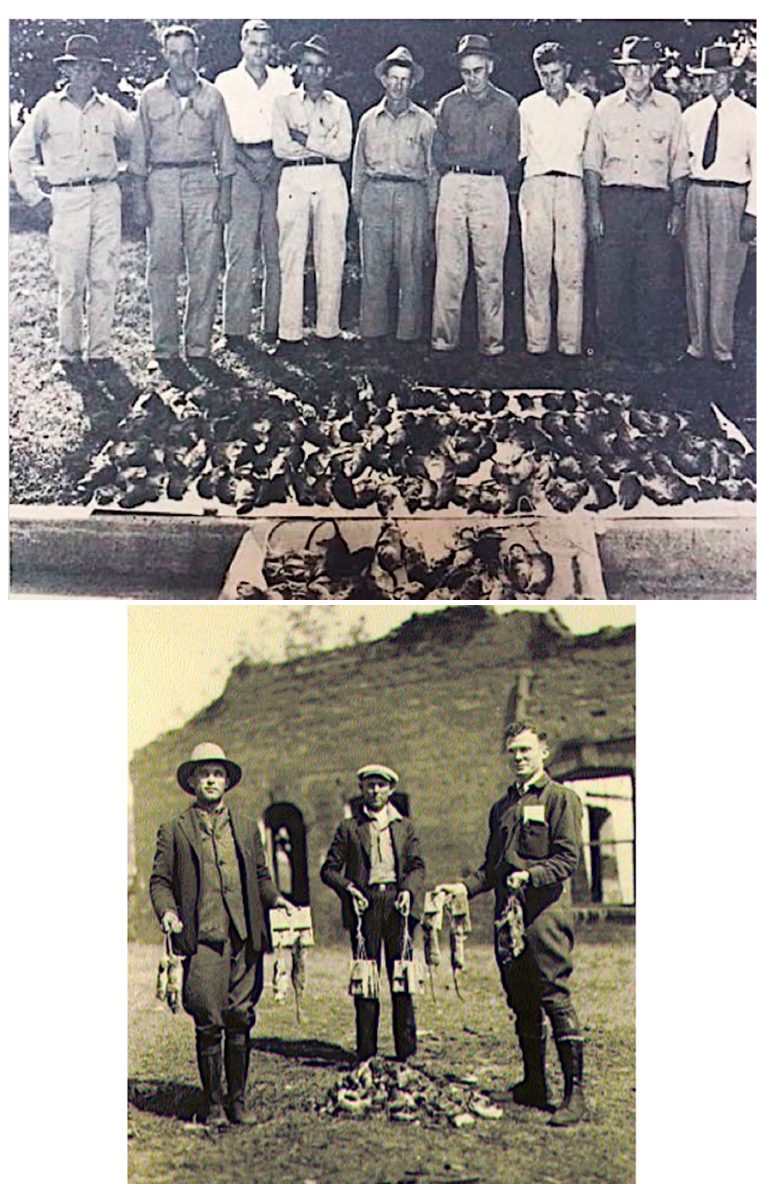
Figure 4. The rat ridders. (upper) Texas rat killing squad, 1930s, proudly displaying their quarry [136]. (lower) Men holding traps and dead rats in Geneva County, Alabama as part of a rat eradication project of the Civil Works Administration, 22 February 1934.